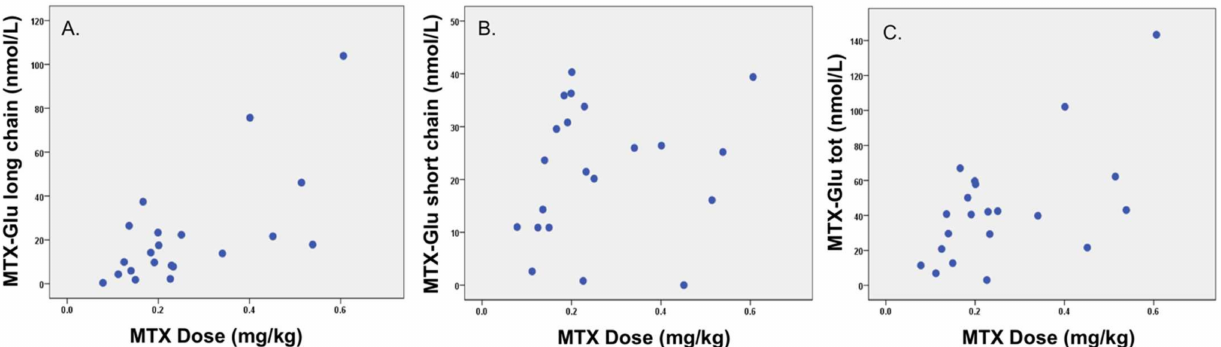
Figure 1. Spearman’s correlation ( (cid:36) ) between methotrexate polyglutamate (MTX-Glu) concentrations and methotrexate (MTX) dose for long-chain MTX-Glu 3–5 , (cid:36) = 0.56; p = 0.009 ( A ); short-chain Glu 1–2 , (cid:36) = 0.27; p = 0.244 ( B ); and total MTX-Glu (MTX-Glu tot ), (cid:36) = 0.51; p = 0.018 ( C ).